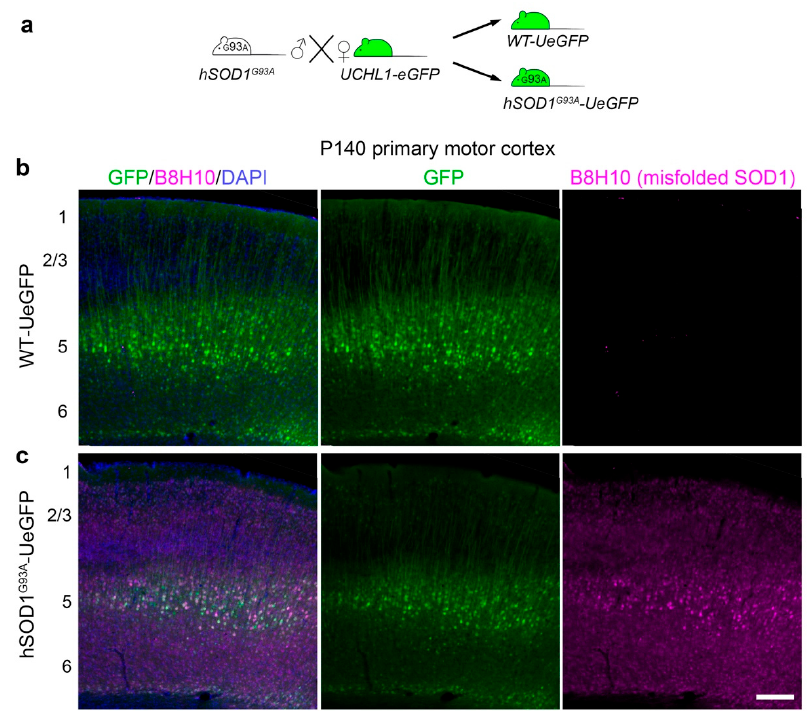
Figure 1. Generation of hSOD1 G93A -UeGFP amyotrophic lateral sclerosis (ALS) reporter mouse model and detection of misfolded SOD1 protein. ( a ) hSOD1 G93A -UeGFP mice were generated by breeding hSOD1 G93A male mice carrying high copy number of human SOD1 protein with a point mutation at position 93 with female UCHL1-eGFP reporter mice that label corticospinal motor neurons (CSMN) with eGFP expression; ( b , c ) B8H10 antibody detects misfolded human SOD1 protein in the primary motor cortex of hSOD1 G93A -UeGFP ( c ) but not WT-UeGFP ( b ) mice. Misfolded SOD1 signal is the brightest in layer 5 where GFP+ CSMN are located. Scale bar, 250 μ m.